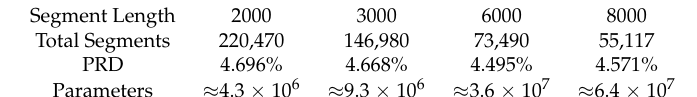
Table 3. Segment Length Evaluation at CR = 27.